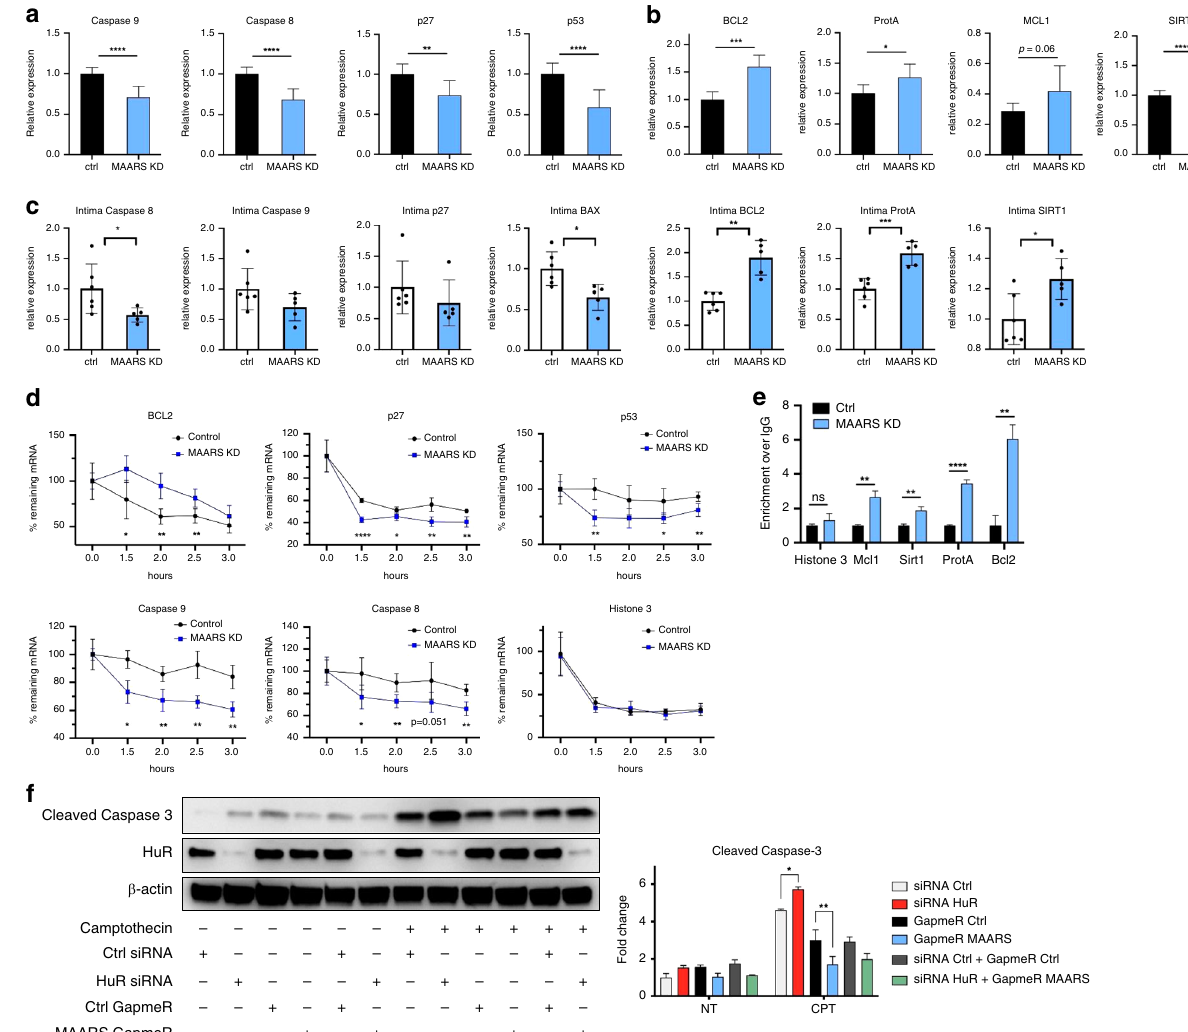
Fig. 5 MAARS knockdown regulates HuR apoptotic targets. a MAARS knockdown decrease pro-apoptosis speci fi c HuR targets in BMDMs transfected with MAARS gapmeRs ( n = 4). b MAARS knockdown increases anti-apoptosis-speci fi c HuR targets in BMDMs transfected with MAARS gapmeRs ( n = 4). c Relative expression of HuR targets in the intima of LDLR − / − mice treated with control ( n = 6) and MAARS gapmeR ( n = 5) (from study in Fig. 2). d mRNA stability studies of HuR targets in BMDMs transfected with control or MAARS gapmeRs and treated with camptothecin (CPT) for 1 h, then activated actinomycin D (100 ng ml − 1 ) for the indicated time points (representative experiment of three independent experiments). e RNA immunoprecipitation (RIP) using HuR-speci fi c antibody in lysates from BMDMs treated with MAARS or control gapmeR (shown is one RIP representative of three independent experiments). f Dependency studies of MAARS and HuR using the indicated gapmeRs and siRNAs, respectively, on cleaved caspase-3 expression in BMDMs treated with or without 20 µ M CPT for 2 h. For all panels values are mean ± SD. * p < 0.05; ** p < 0.01; *** p < 0.001; **** p <